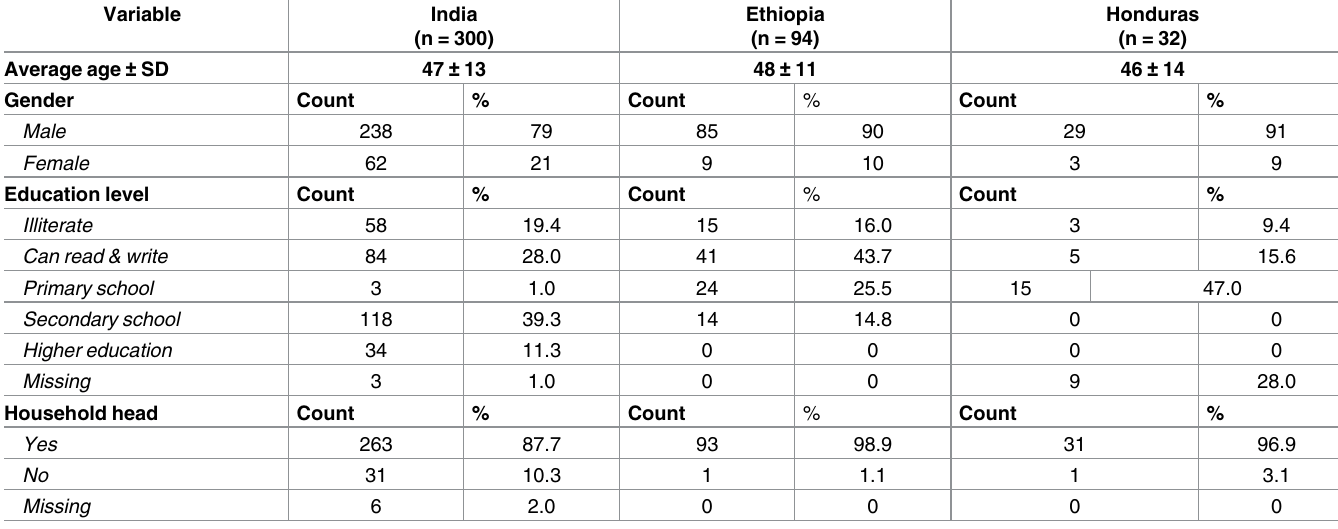
Table 2. Demographic characteristics of the surveyedfarmersin the three